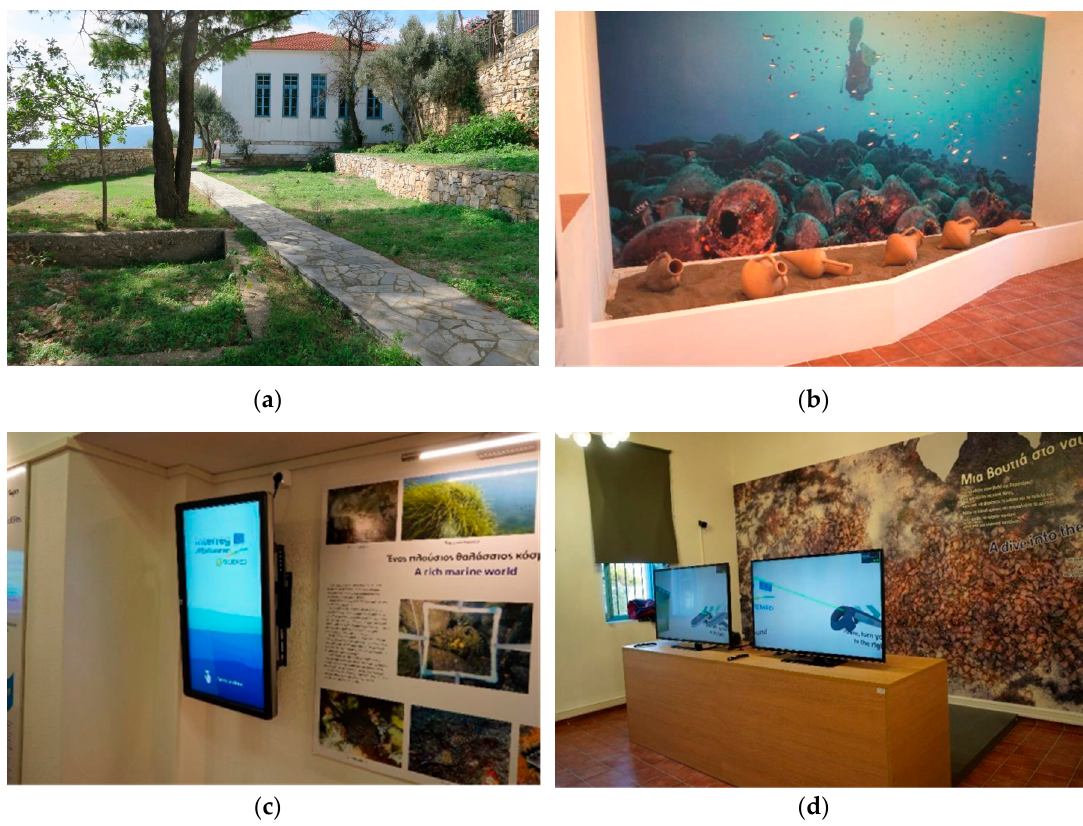
Figure 11. Some pictures of the Alonissos KAC: ( a ) the old elementary school of Alonissos island where the KAC has been realized; ( b ) sandbox with some replica of amphorae and the giant poster of the “Peristera” shipwreck placed above it; ( c ) touchscreen with the application for “Marine Biology” attached to one of the hallway walls; ( d ) Virtual Diving system arranged in the “Exhibition” room. Among the activities of the KAC, guided visits are also planned for divers along specific underwater trails at the accessible underwater archaeological site of Peristera, one of the BLUEMED pilot